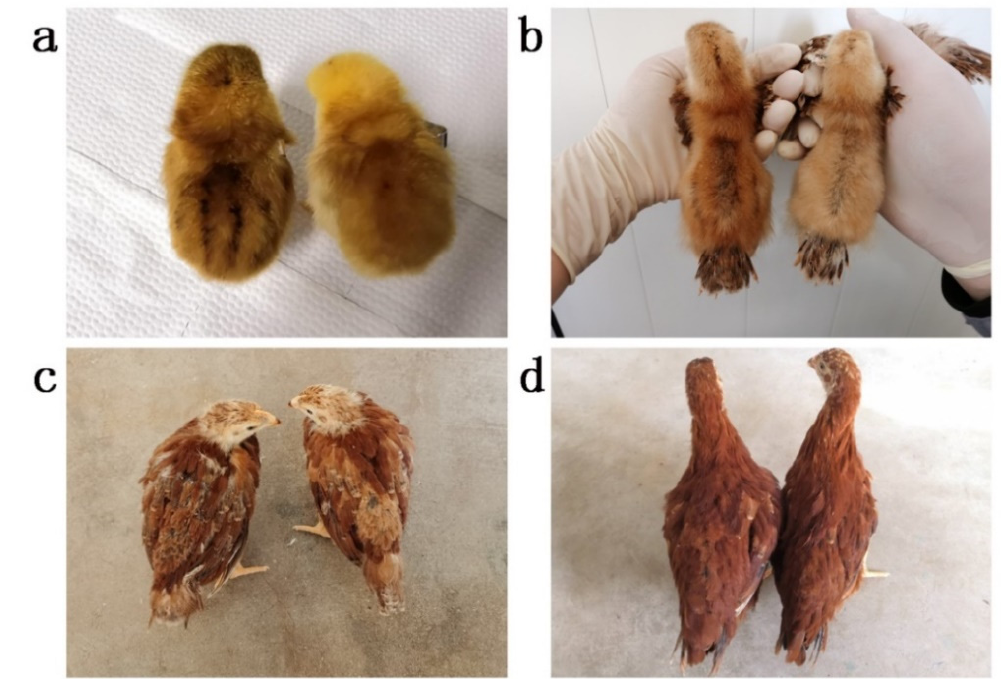
Figure 1. Stripe pattern and non-stripe pattern female RIR chickens of different ages. ( a ) 1-day-old; ( b ) 13-day-old; ( c ) 28-day-old; ( d ) 46-day-old. In each picture, the stripe pattern and non-stripe pattern are left and right, respectively. As the chick grows, the downy feathers are gradually replaced with youth feathers and the stripe pattern disappears.